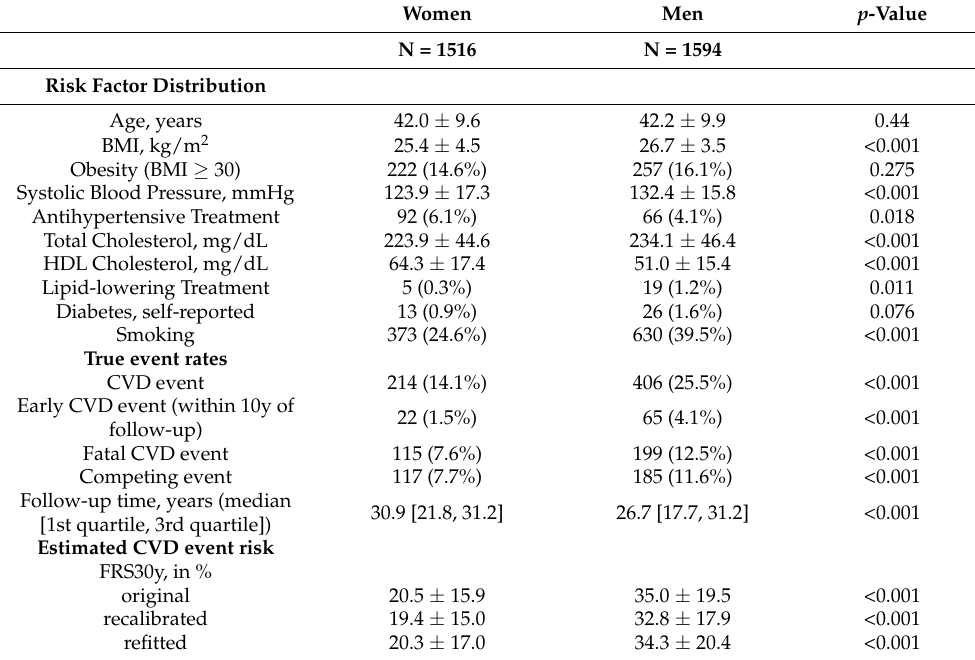
Table 1. Baseline characteristics of study sample and estimated risk by original, recalibrated and refitted version of FRS30y and true event rates. Data are given as mean ± standard deviation for continuous covariates, unless otherwise indicated. Data are given as counts (percentage) for categorical covariates. p -values from t -Test or χ 2 -Test, where